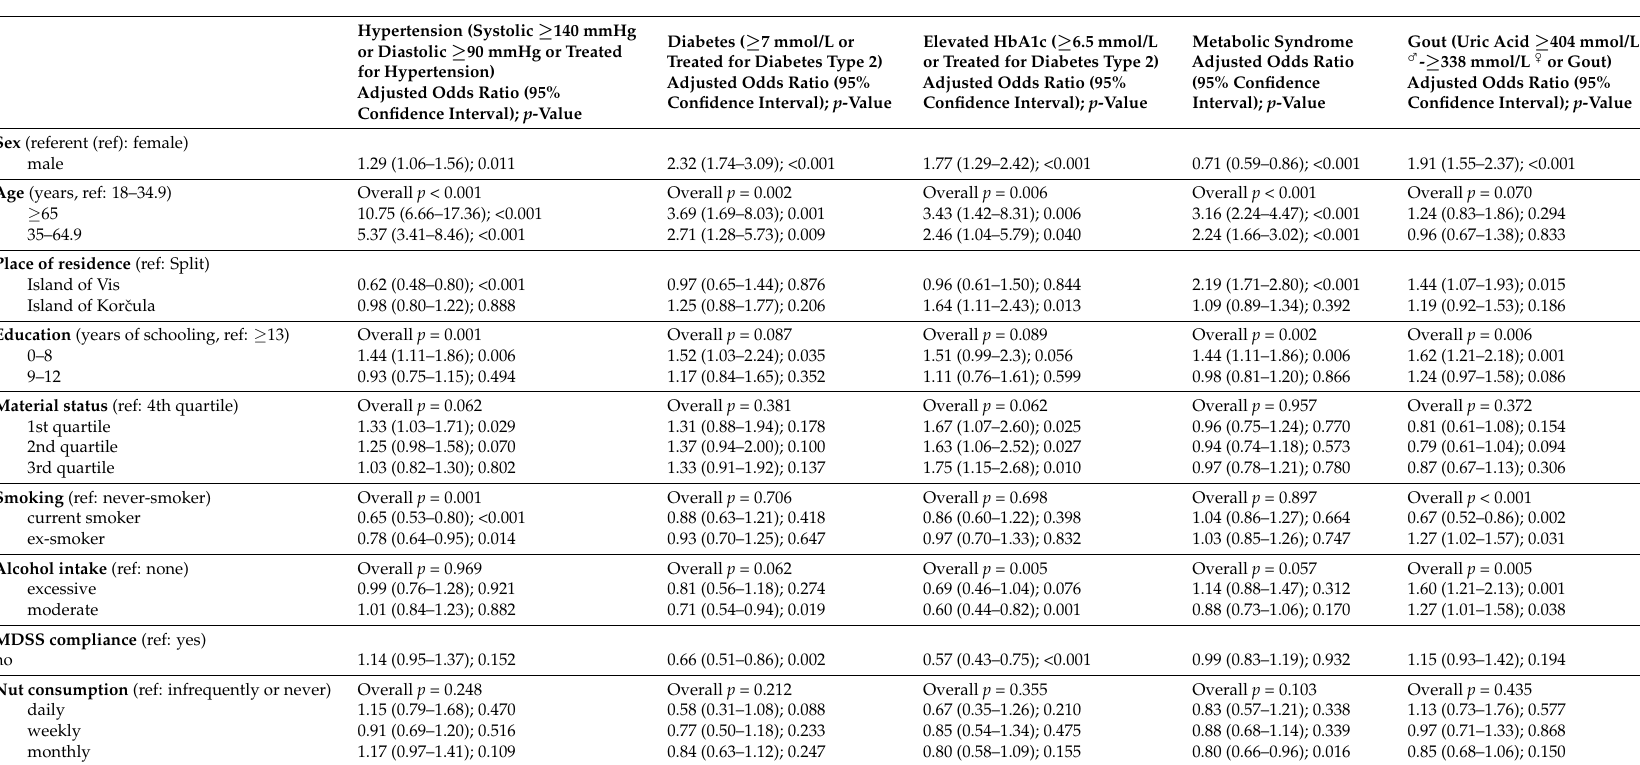
Table 5. Characteristics associated with hypertension, diabetes, metabolic syndrome and gout as determined by the multivariate logistic regression analyses (sample size is 4011 subjects without previous cardiovascular disease diagnosis; all independent variables included in the model are listed in the